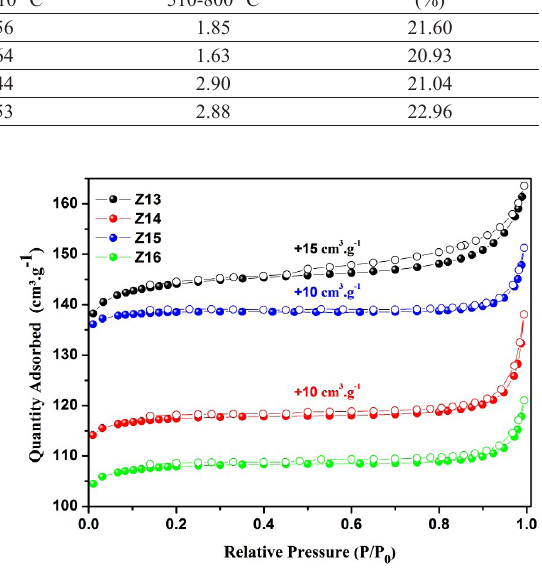
Figure 4. N 2 adsorption-desorption isotherms of the SSZ-13 samples.